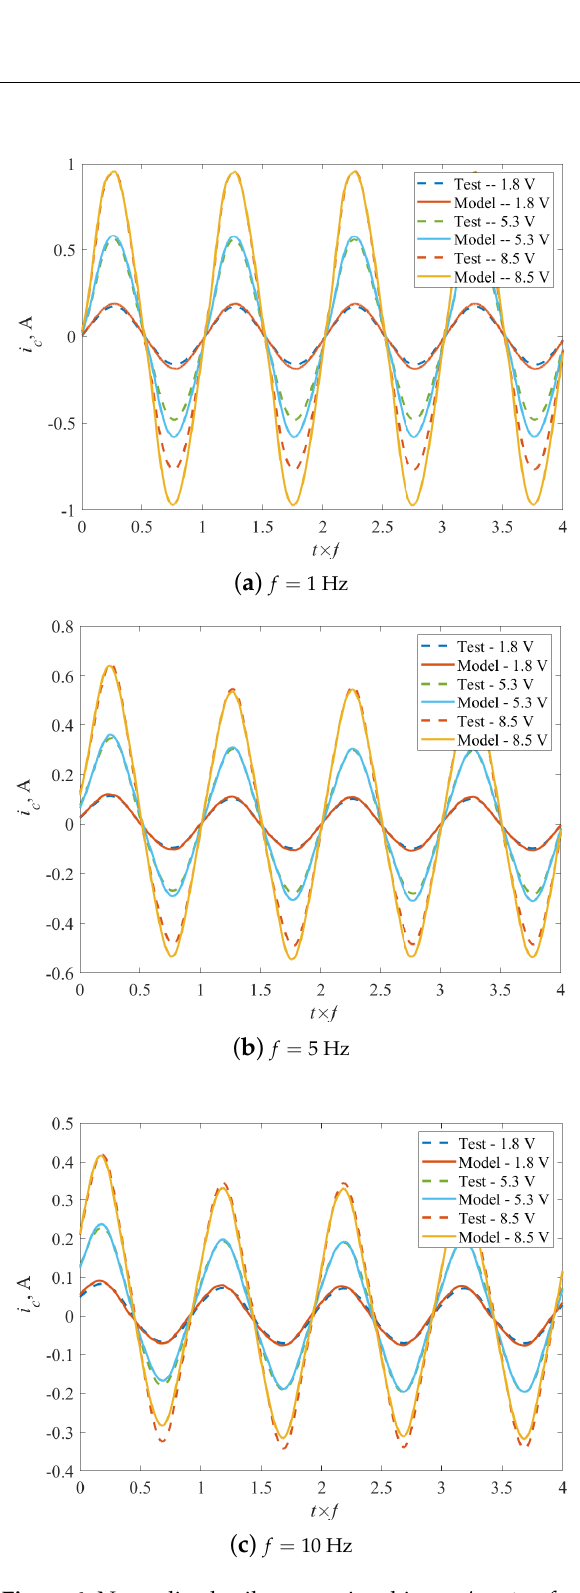
Figure 6. Normalized coil current time history i c − t × f : model vs.